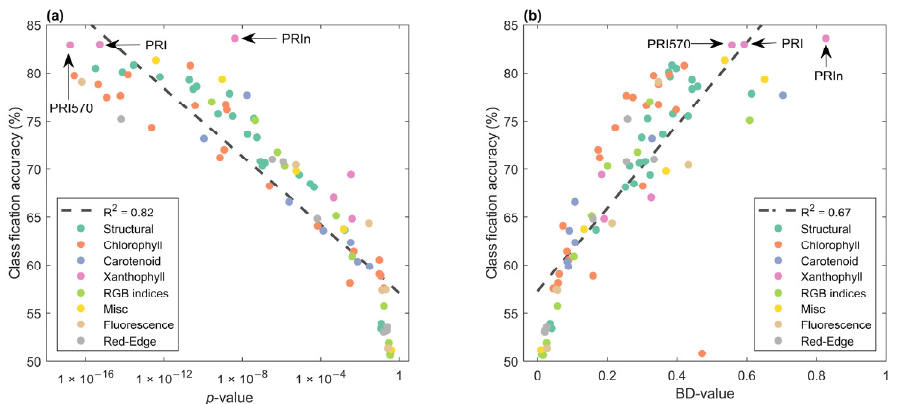
Figure 7. Mean classification accuracy over 16 dates ( y -axis) and mean variable on the x -axis. ( a ) p -values from a 2-sample t -test (H0 = means for treatments were the same). Noteworthy indices with the highest classification accuracy are indicated with arrows. Spearman’s rho for the first n identified VIs using the ‘new search algorithm’ was − 0.54. Colors were used for VI groupings. ( b ) Bhattacharyya distances vs classification accuracy per VI, Spearman’s rho for the first n identified VIs using the ‘new search algorithm’ was 0.43.